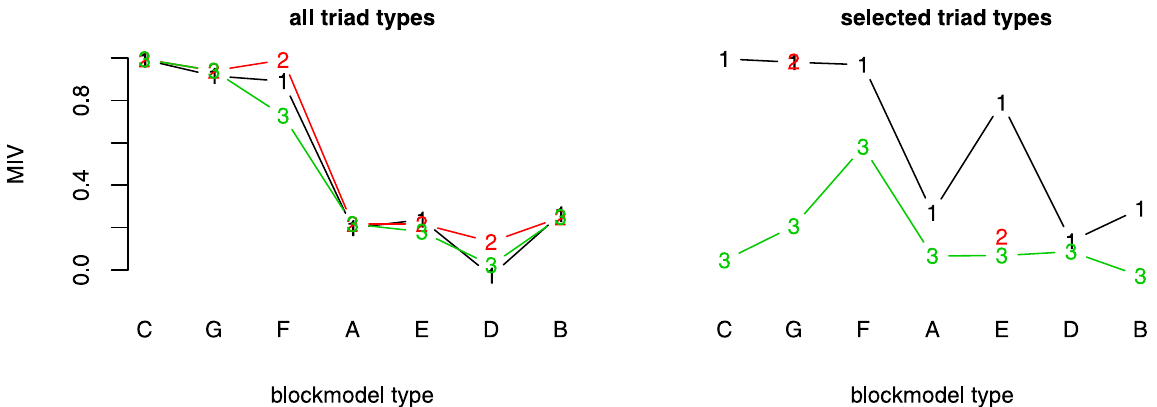
Fig 8. The MIV for each blockmodel type (generated by the MCMC algorithm with variable density) and selected set of triad types. (A) cohesive; (B) symmetric core-periphery; (C) asymmetric core-periphery; (D) hierarchical without complete blocks on the diagonal (E) hierarchical with complete blocks on the diagonal; (F) transitivity without complete blocks on the diagonal; (G) transitivity with complete blocks on the diagonal, (1) allowed and forbidden triad types, (2) allowed triad types, (3) forbidden triad types. Note: only the networks of transitivity with complete blocks on the diagonal blockmodel type and hierarchical with complete blocks on the diagonal blockmodel type were generated by considering the selected allowed triad types.